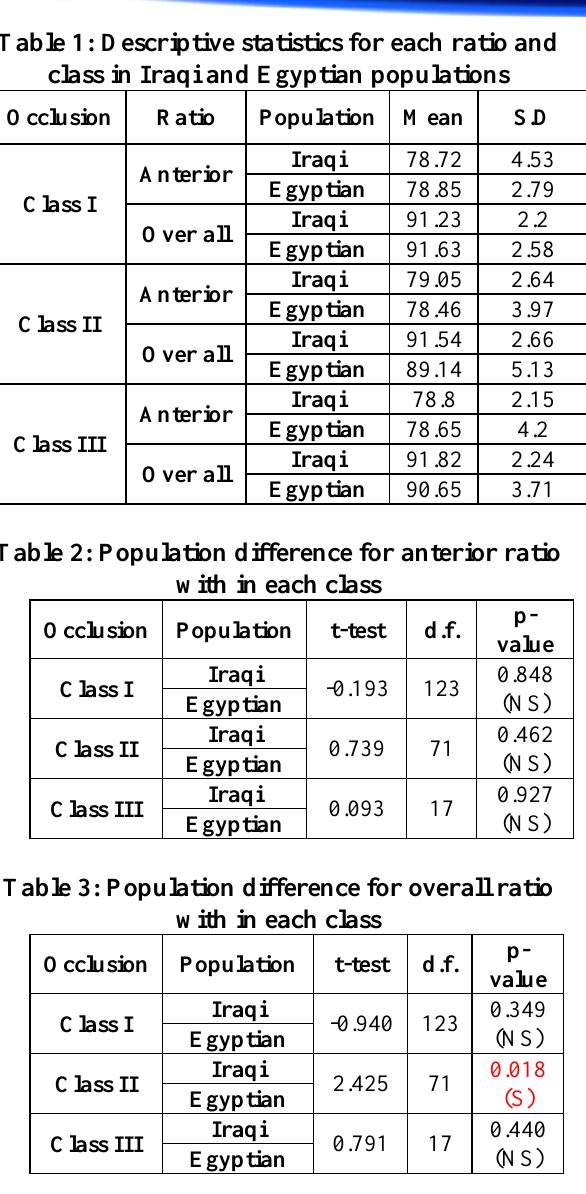
Table 4: Classes' difference for each ratio